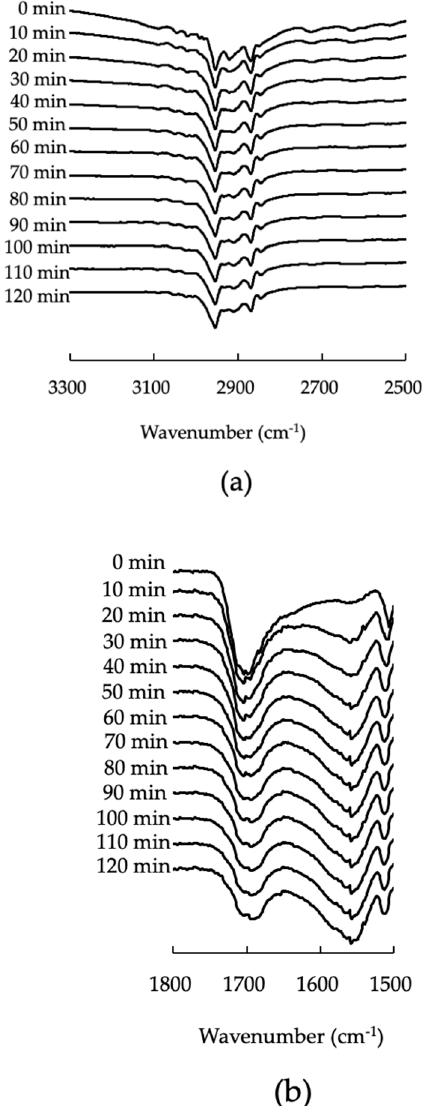
Figure 7. FTIR spectra of 50% PS300-PM, at different time points (0–120 min), at 70 °C. ( a ) From 3300–2500 cm − 1 ; ( b ) from 1800–1500 cm − 1 .